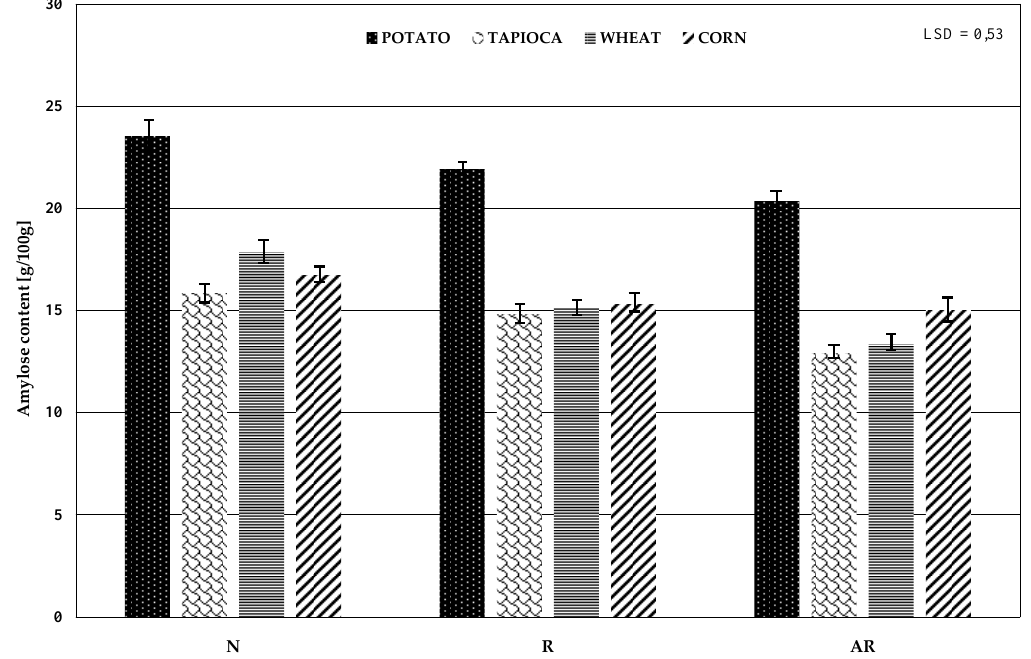
Figure 2. Contents of amylose in native (N), retrograded ®, and acetylated retrograded (AR) starch of various botanical origins.